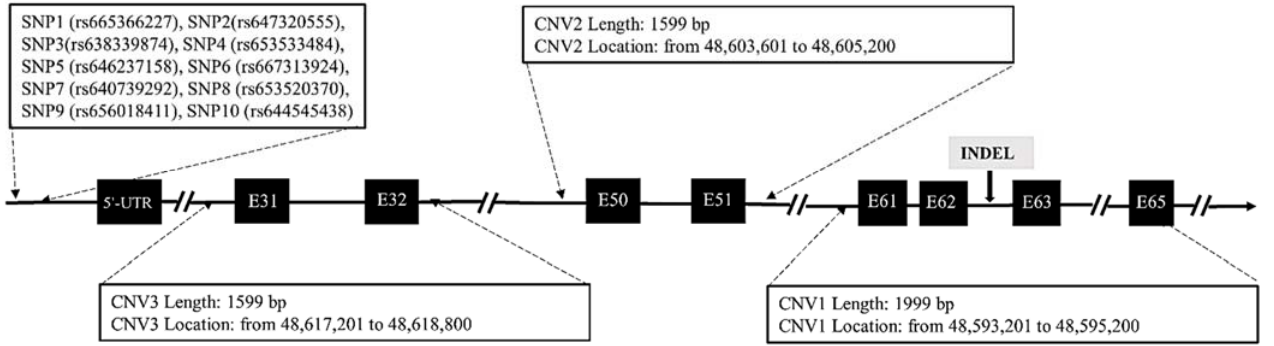
Figure 1. Genome map that indicates the location of the SNP, InDel and CNV mutations in goat DNAH1